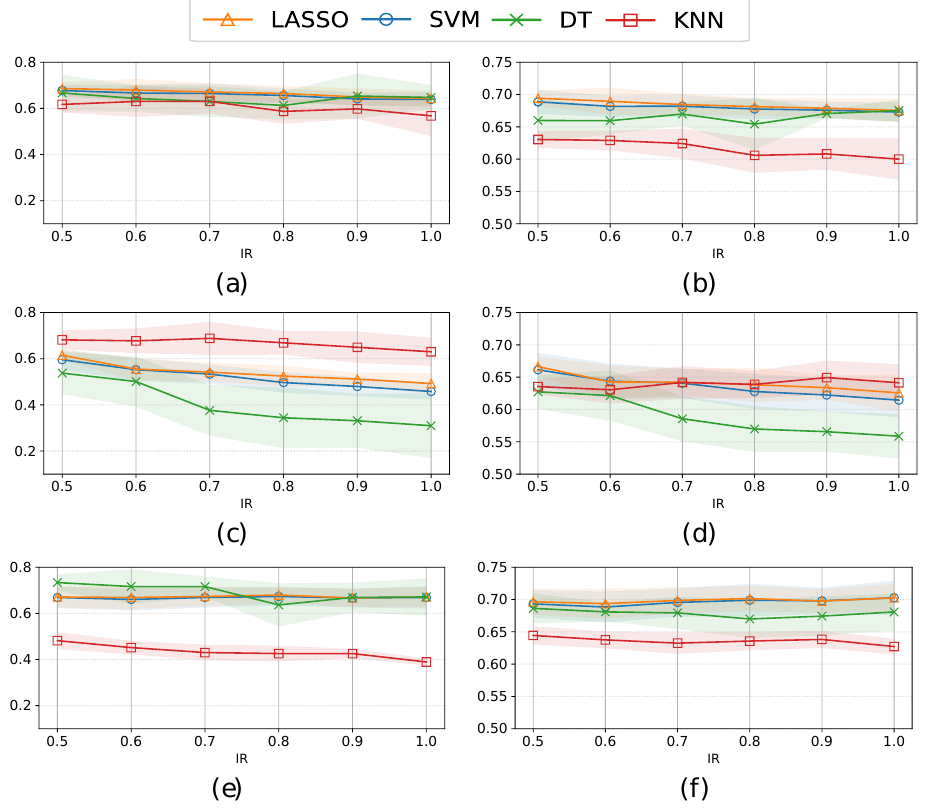
Figure 6. Mean ± std of the sensitivity (left panels) and AUC (right panels) considering 5 test subset partitions and different IR values, classifiers, and a hybrid approach (by combining undersampling and oversampling strategies) with: ( a , b ) SMOTEN; ( c , d ) TVAE; and ( e , f )